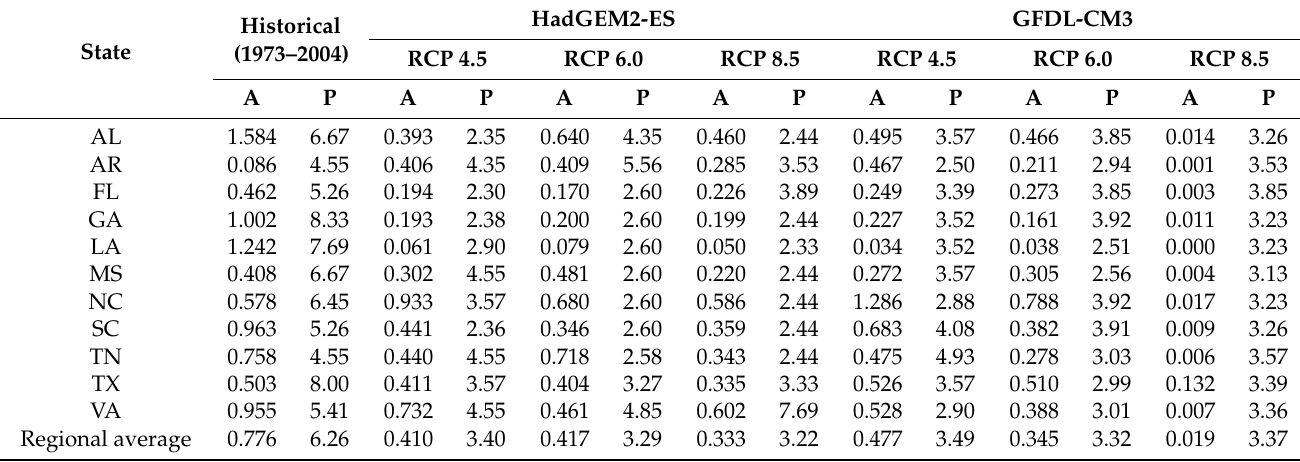
Table 2. Amplitudes and periods of cyclical patterns of historical and projected southern pine beetle (SPB) infestations in the Southern United